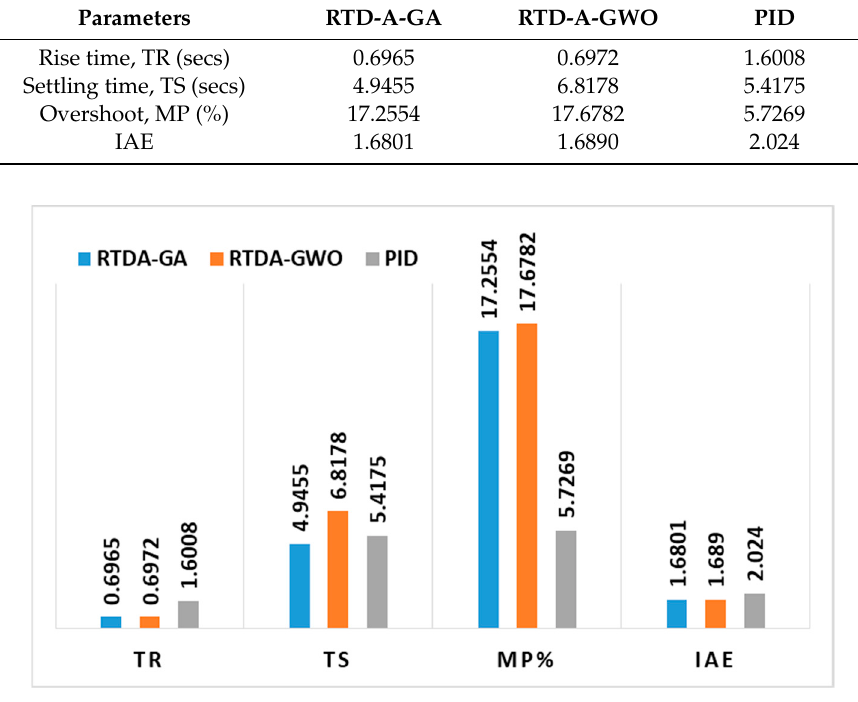
Figure 8. Closed loop response with RTD-A and proportional integral derivative (PID) for the first- order process with dead time (FOPDT) process. Table 7. Performance comparison of RTD-A and PID for the FOPDT model. Table 7. Performance comparison of RTD-A and PID for the FOPDT model.